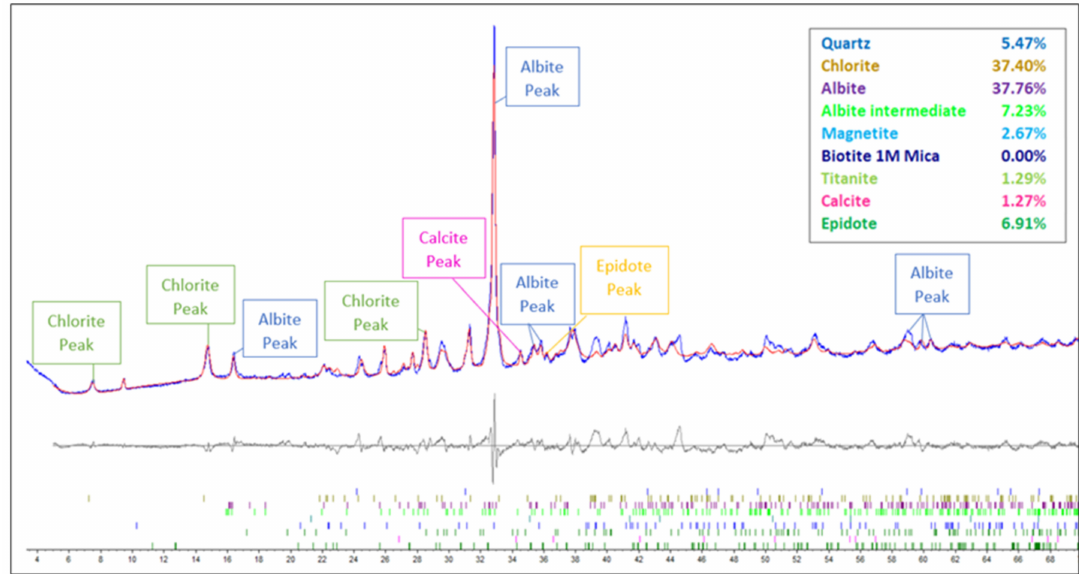
Figure 14. XRD pattern for the geopolymer activated with 100% NaOH.